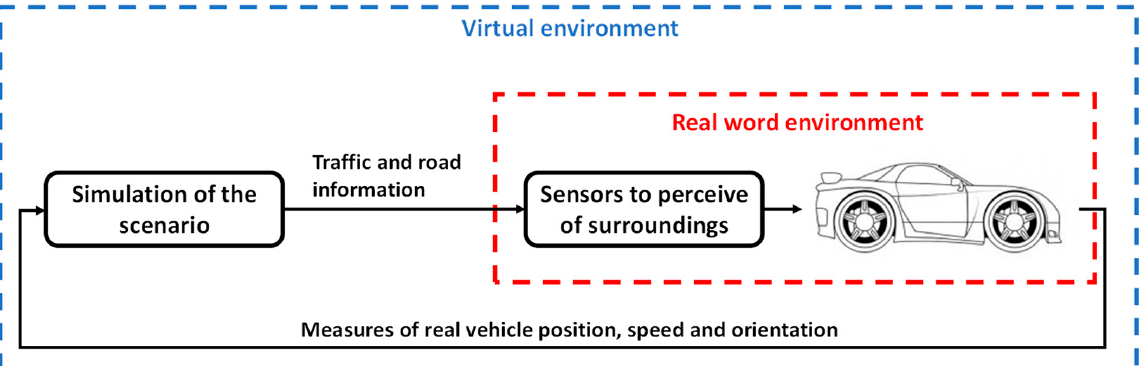
Figure 4. ViL test architecture schematization. Table 3. Typical ViL/Driving Test Setups.